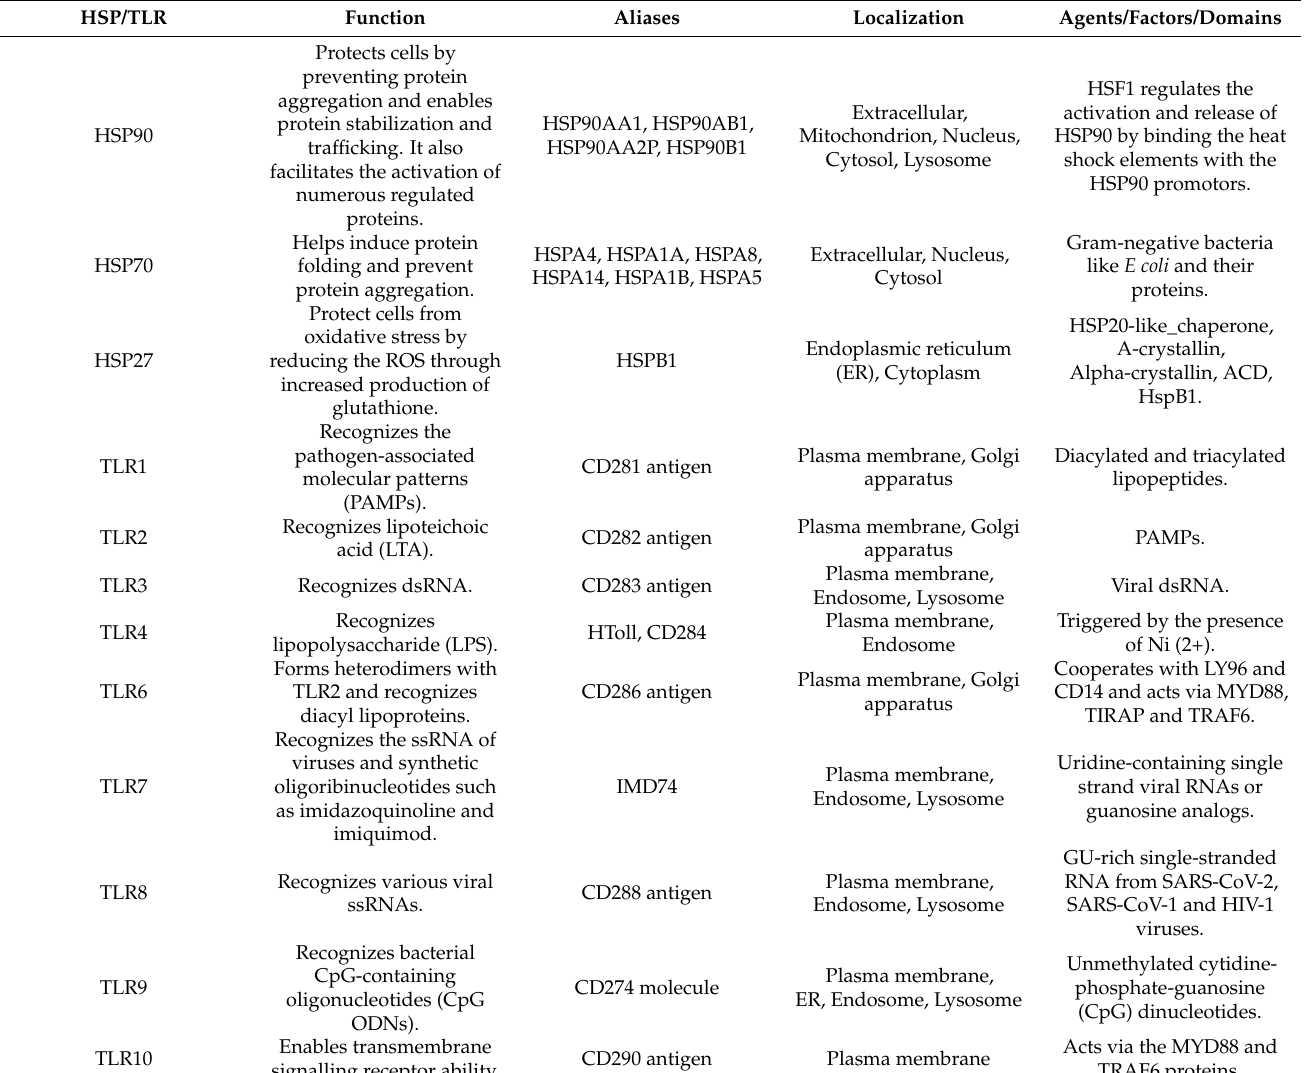
Table 2. Characterization of heat shock proteins (HSP) and Toll-like receptors (TLR) activated during heat stress.